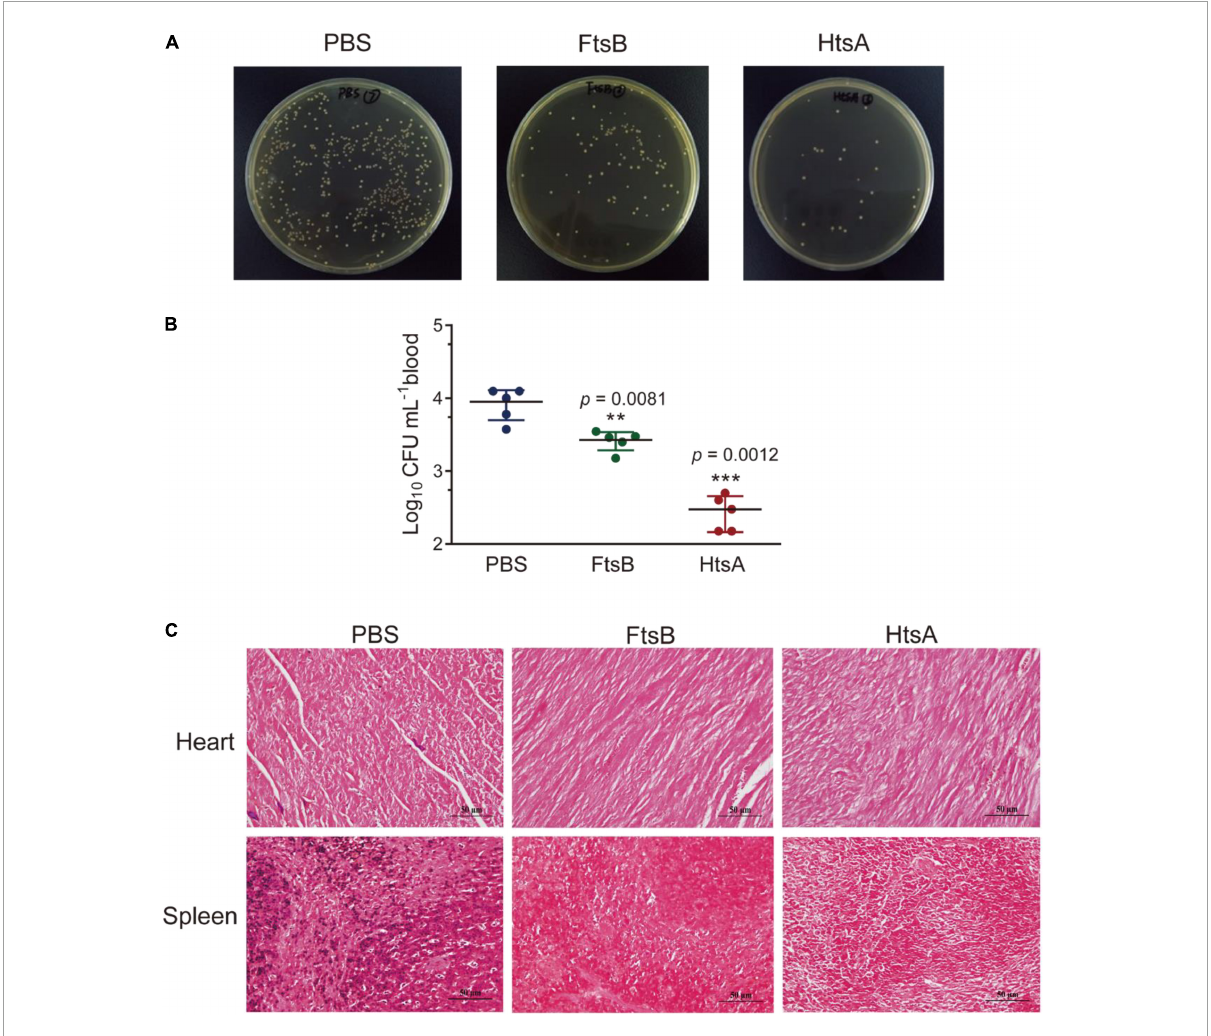
FIGURE3 Immunization with the FtsB protein reduced the bacterial burden in a murine bacteremia model. (A,B) Bacterial loads in the blood of mice immunized with different antigens determined 6 h after infection with 5 × 10 6 S. pyogenes MGAS5005 ( n = 5). (C) The bacterial loads in the heart and spleen of mice. Gram staining of the heart and spleen of mice after 48 h of challenge with S. pyogenes (400 × ). n = 5 mice per group, ** p < 0.01, *** p < 0.001 vs. PBS control